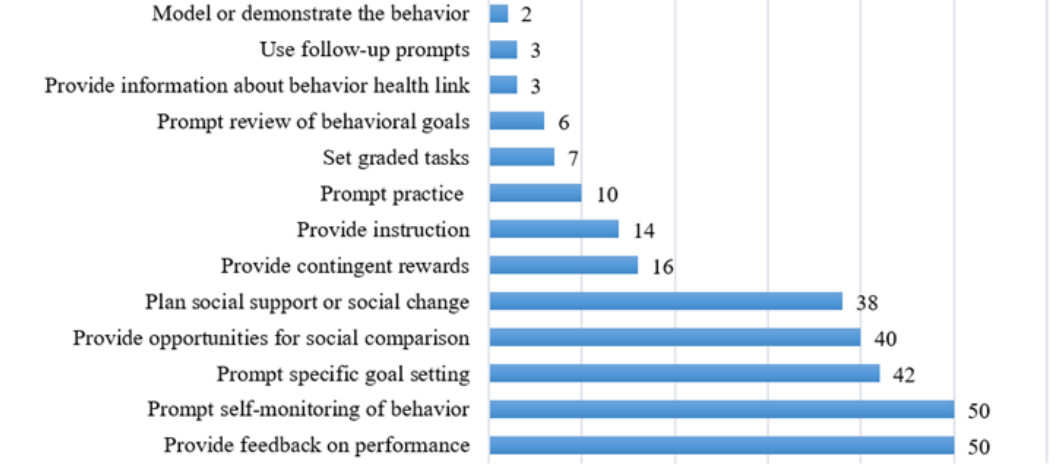
Figure 2. Frequencies of the 23 behavioral change techniques presented in the included apps